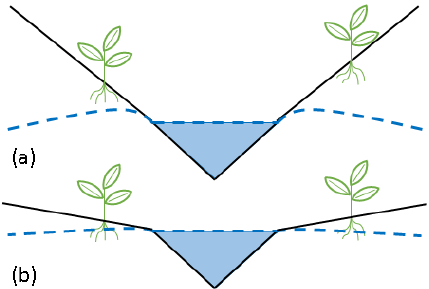
Figure 6. The roots of plants growing on a (a) steep slope will be farther from the locally raised water table created by a sand dam and therefore have less access to soil water than vegetation growing on a (b) gentle